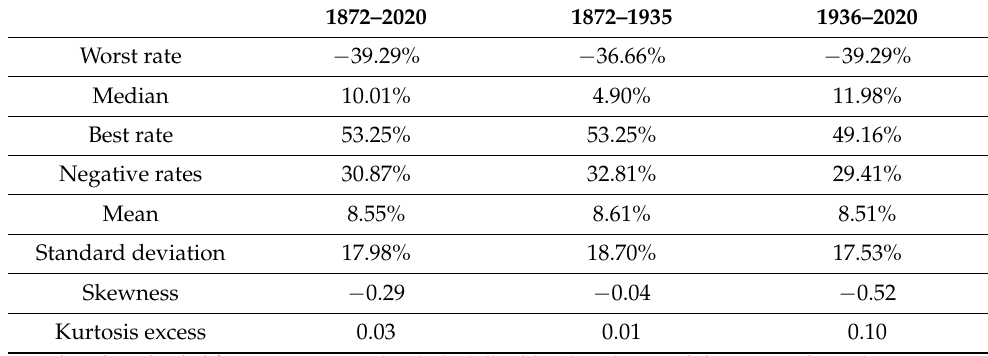
Table 4. Annual real rates of linear return, 1872–2020, two subperiods.